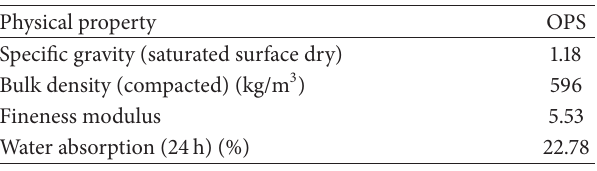
Table 2: Physical properties of OPS aggregate.